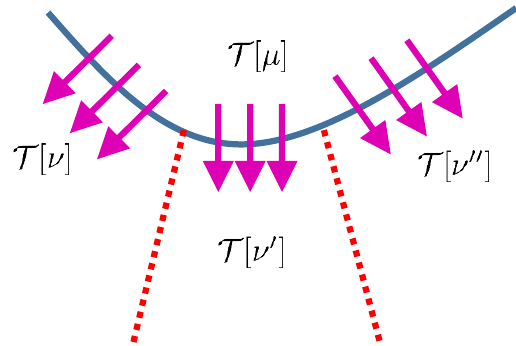
Figure 2. Depiction of the deformations from one nilpotent orbit to another. Here, we label a theory by a choice of nilpotent orbit T [ (cid:22) ], and subsequent deformations deeper down in the nilpotent cone to theories T [ (cid:23) ], T [ (cid:23) 0 ] and T [ (cid:23) 00 ]. These physical paths to new orbits are parameterized by the remnants of the original mesonic operators. An important subtlety with this picture is that as we proceed from the UV to the IR, various mesonic operators may decouple, severing some of the candidate links between theories. In explicit examples, however, we have not observed this pathological